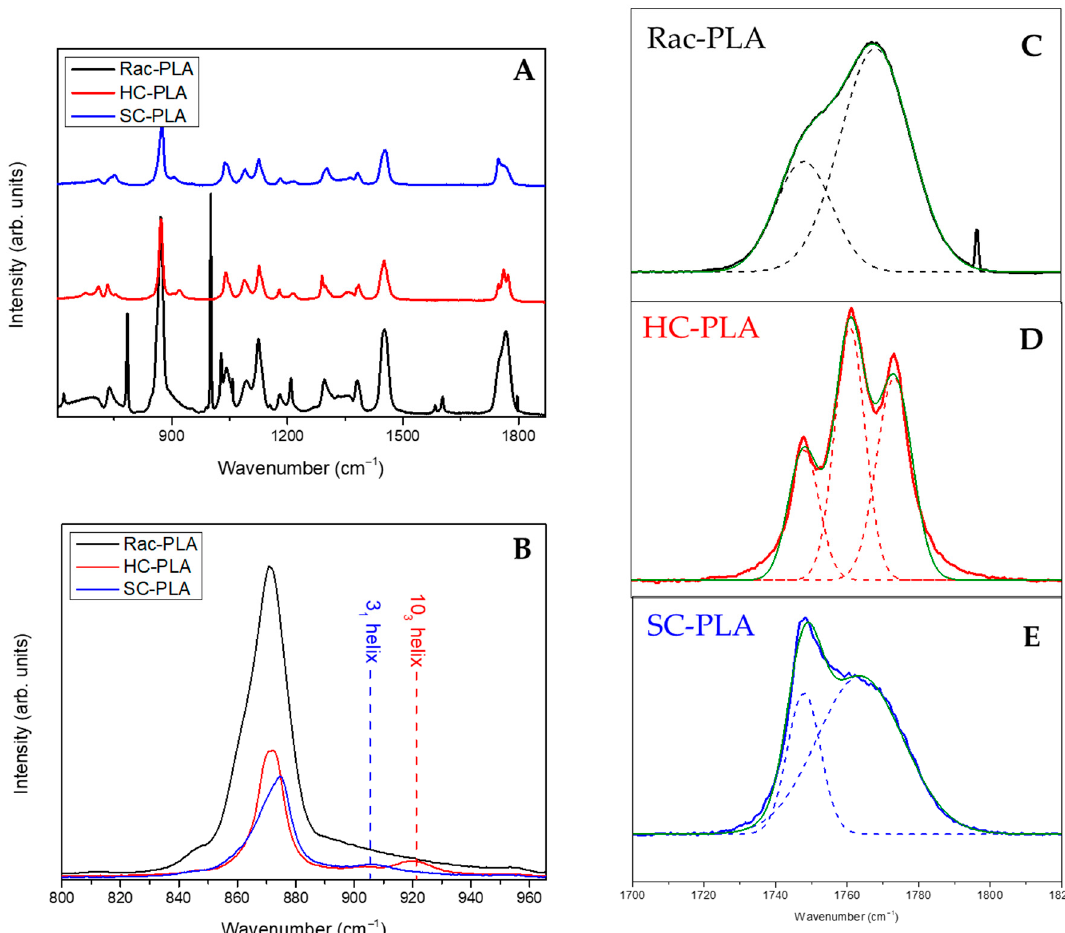
Figure 2. Full Raman spectrum of the bulk polymers ( A ), C-COO stretching Raman region of the bulk polymers ( B ) and carbonyl region of the Rac-PLA ( C ), HC-PLA ( D ) and SC-PLA ( E ).